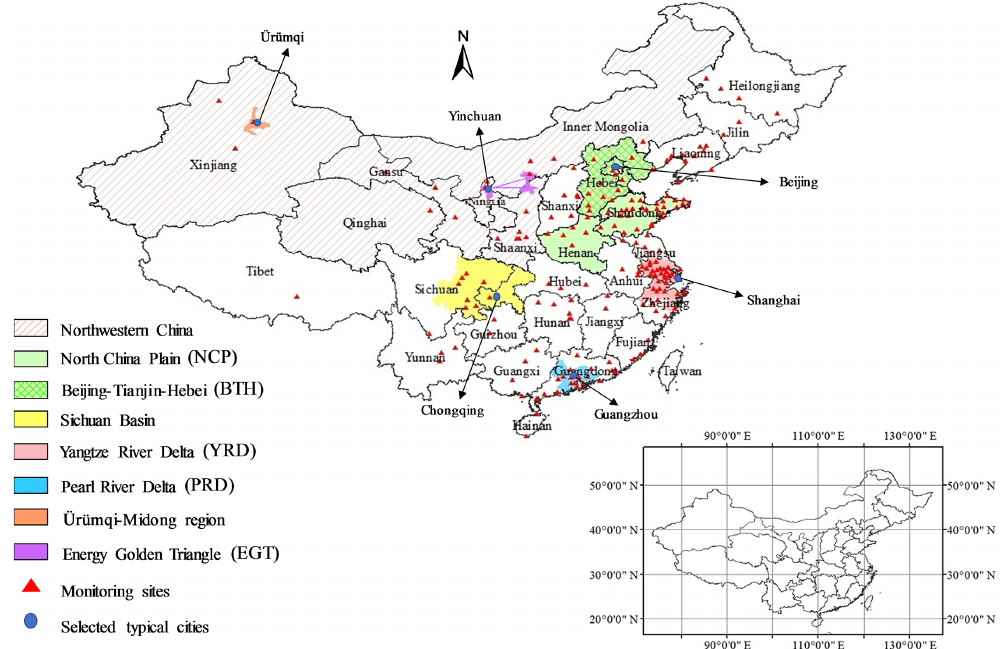
Figure 1. Selected regions in this investigation across China, including northwestern China, defined by slash, which includes Inner Mongolia, Shaanxi, Gansu, Qinghai, Ningxia, Beijing–Tianjin–Hebei (BTH), the North China Plain (NCP), the Sichuan Basin, Yangtze River Delta (YRD), and Pearl River Delta (PRD). These regions are labeled in the figure and marked by different colors. The Ürümqi–Midong region (brown) and the Energy Golden Triangle (EGT, purple) are also labeled in the figure. Red triangles indicate 188 monitoring sites across China. Blue circles indicate six selected cities in Fig.